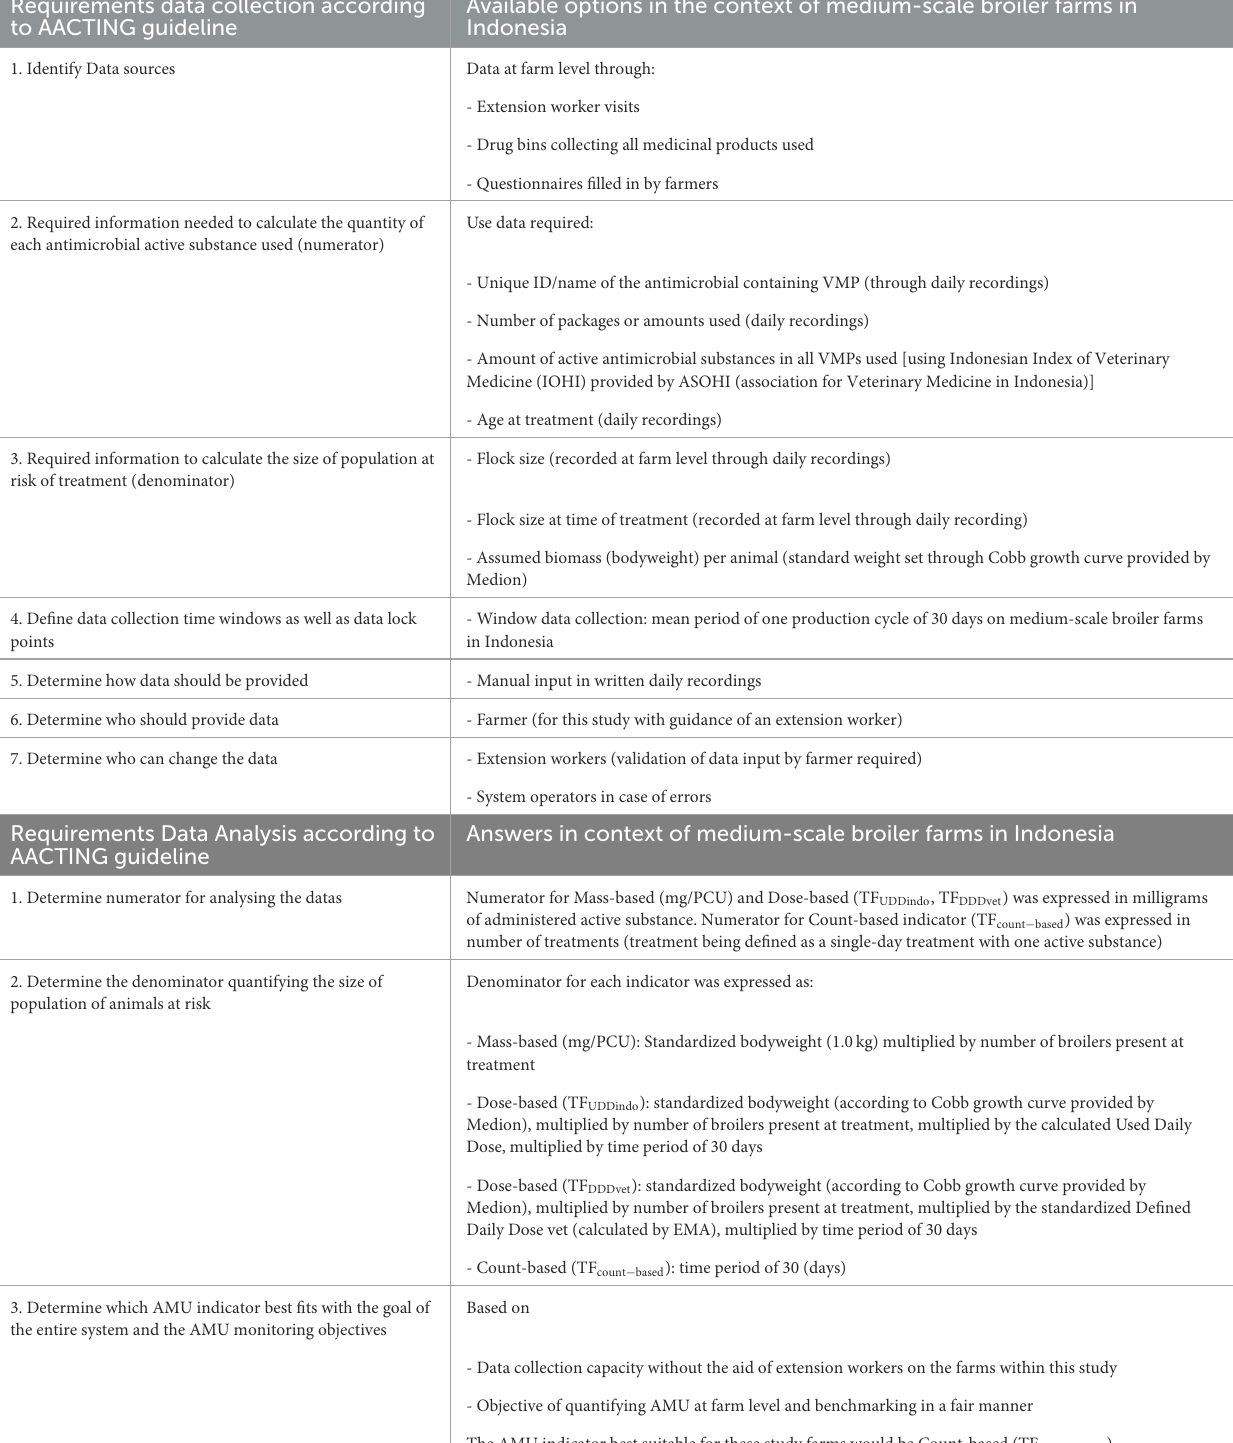
TABLE 2 Checklist for developing an AMU monitoring system in the context of Indonesian medium-scale broiler farms. Requirements data collection according to AACTING